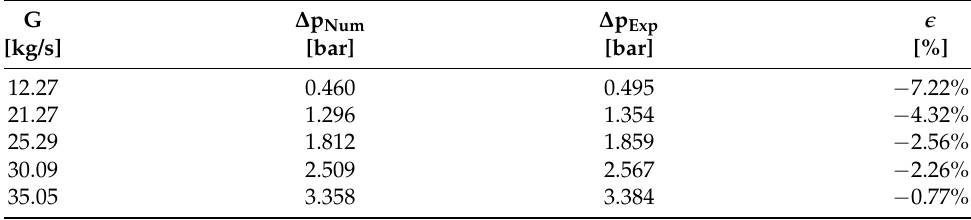
Table 8. Total pressure drop comparison and